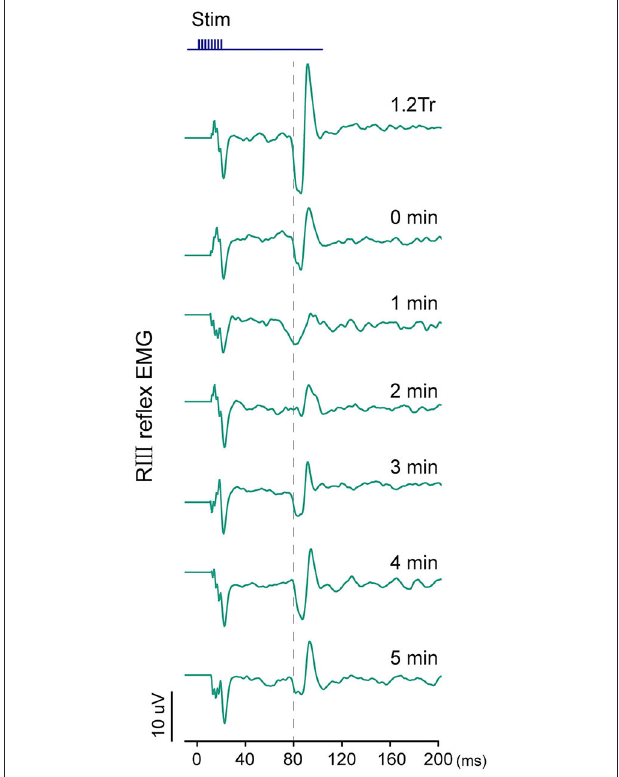
FIGURE 5 | Examples of the changes in RIII reflex EMG at baseline by 1.2 Tr, immediately after (0min), and 1–5min after electroacupuncture (EA) application in the juice groups at week